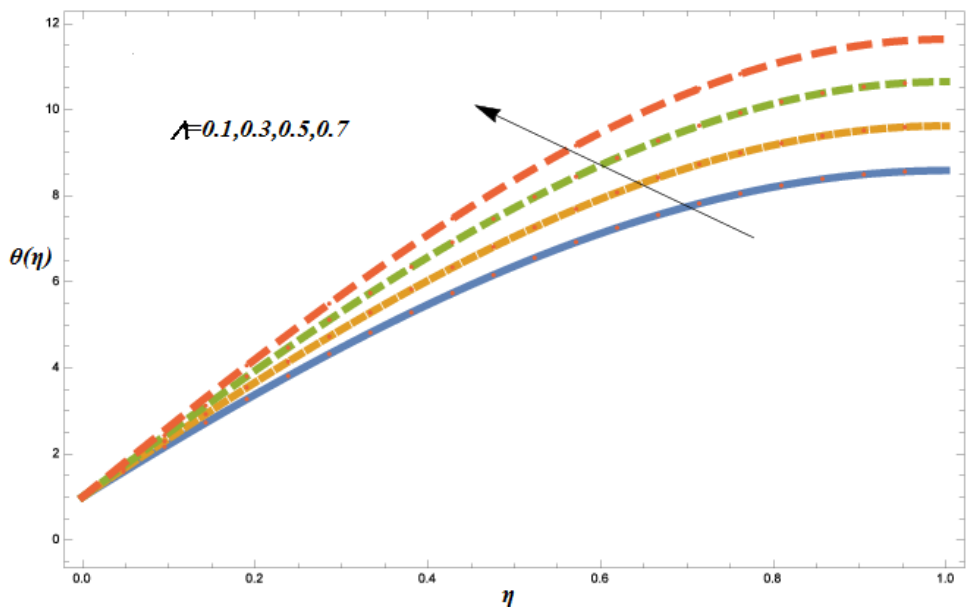
Figure 19. Variations in velocity field f (cid:48) ( η ) for various values of Λ , when (cid:125) = − 0.25, P r = 10, S c = 0.7, λ = 0.7, D u = 0.7, β = 1, S = 0.7.